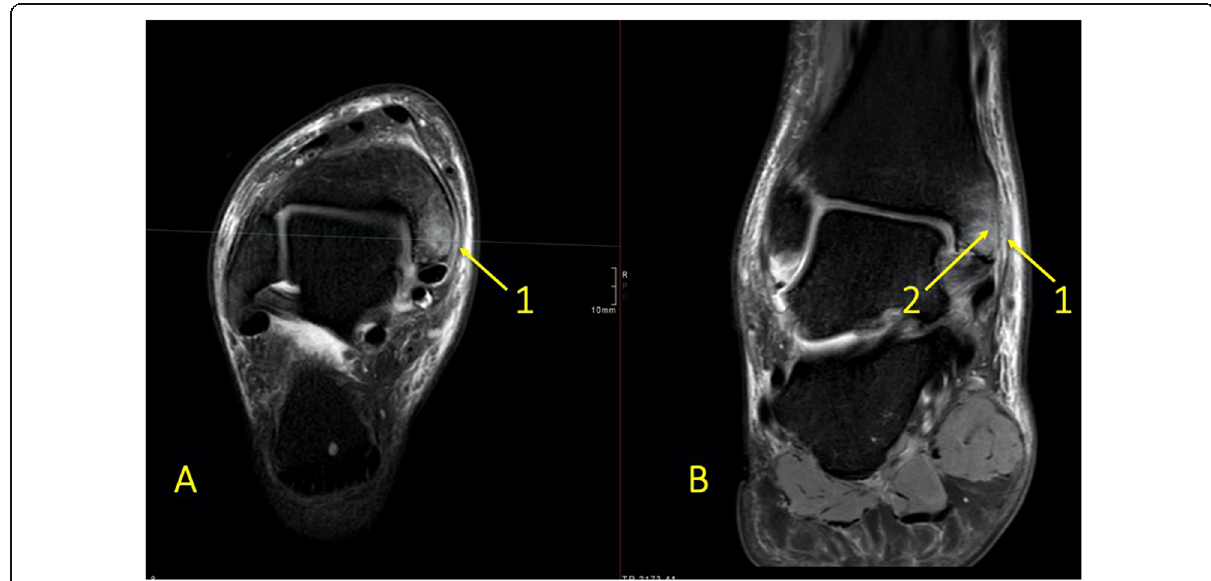
Fig. 7 A 39-year-old male imaged 10 days after an ankle injury on suspicion of deltoid ligament rupture. MRI showed (1) partial injury of the flexor retinaculum with (2) BME in the medial malleolus